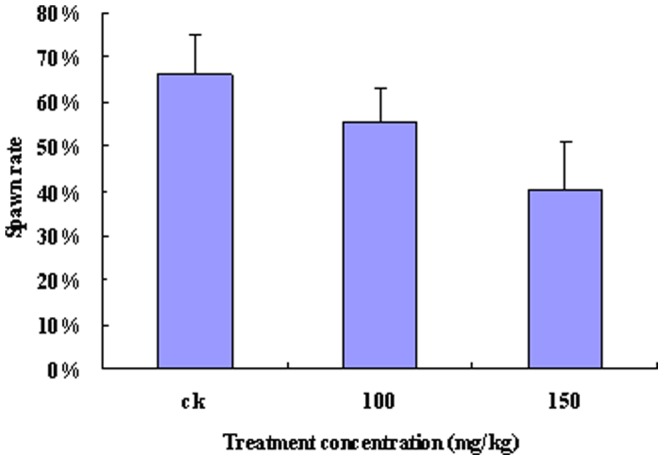
Rate of offspring in Harmonia axyridis.Female H. axyridis adults were divided into three groups and starved for 24 h before the experiment. One H. axyridis female adult was placed in each tube containing 140 aphids (from the broad beans watered with Zn2+ solutions of 0, 100 or 150 mg/kg) and allowed to feed for 24 h. The ovipositioning rate of each beetle was then determined. (Tukey's test, α = 0.05, a>b>c)